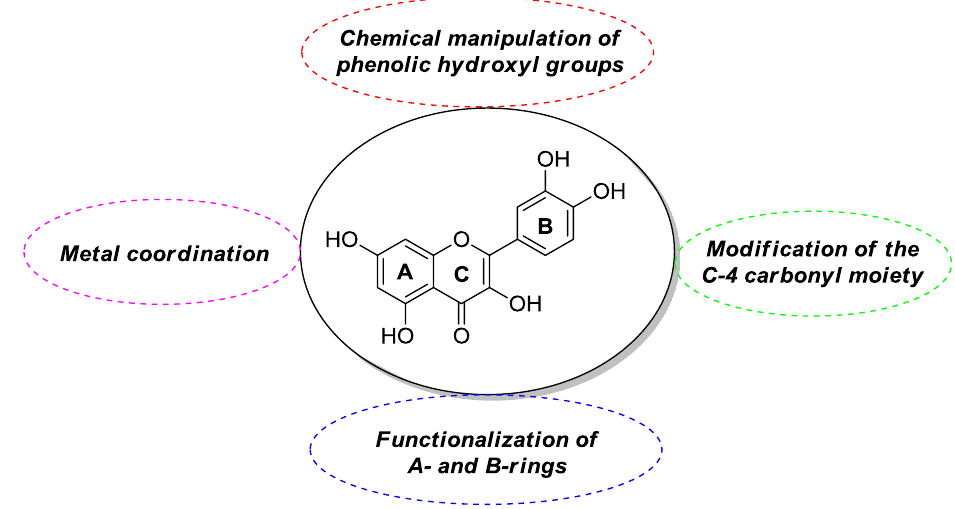
Figure 3. General methodologies towards modified forms of quercetin.